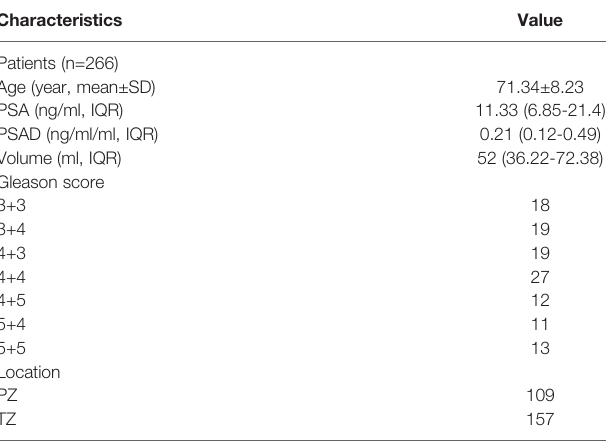
TABLE 1 | Patient characteristics. Clinical Characteristics of Patients Analyzed in This Study. Characteristics